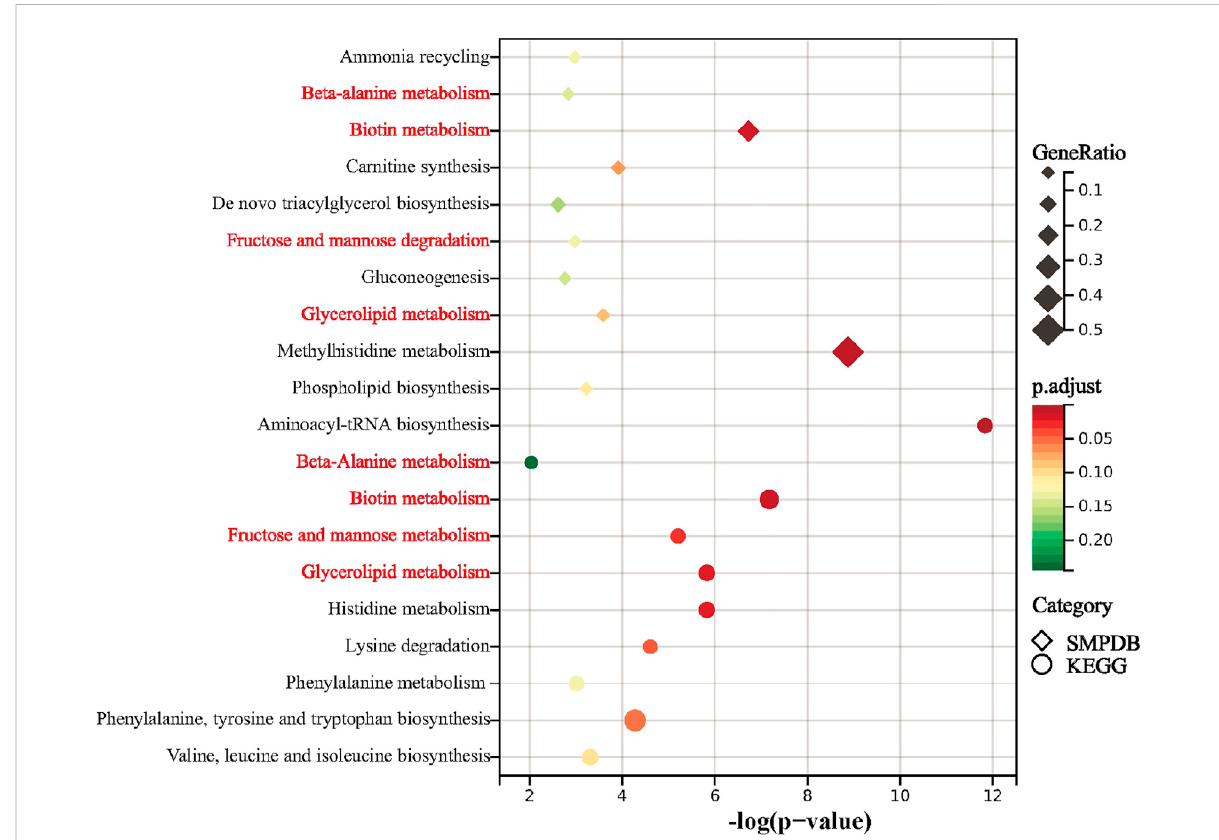
FIGURE 4 Summary plot for KEGG and SMPDB. Metabolic pathway analysis of pSS-altered metabolites using MetaboAnalyst 5.0 based on the KEGG and SMPDB. Triangles and circles colors indicate pathway enrichment signi fi cance, triangles and circles size indicates the extent of pathway impact, common pathways are marked in red.